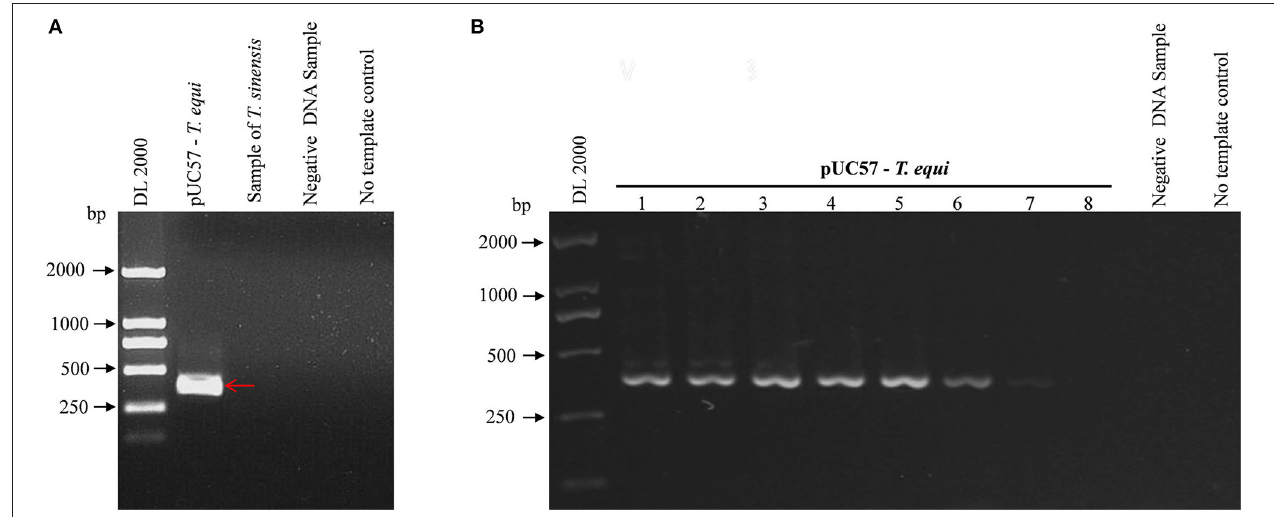
FIGURE 2 | Specificity and sensitivity of pUC57- T. equi detected by nested PCR. (A) Specificity of the nested PCR. T. sinensis is unrelated DNA and used as a control. (B) Sensitivity of the nested PCR. Lane 1-8, this experiment was carried out using different concentrations of pUC57- T. equi DNA (ng): 1 × 10 − 1 , 1 × 10 − 2 , 1 × 10 − 3 ,1 × 10 − 4 , 1 × 10 − 5 , 1 × 10 − 6 , 1 × 10 − 7 , and 1 × 10 − 8 , respectively. All PCR products were electrophoresed on 1% agarose gels and stained with ethidium